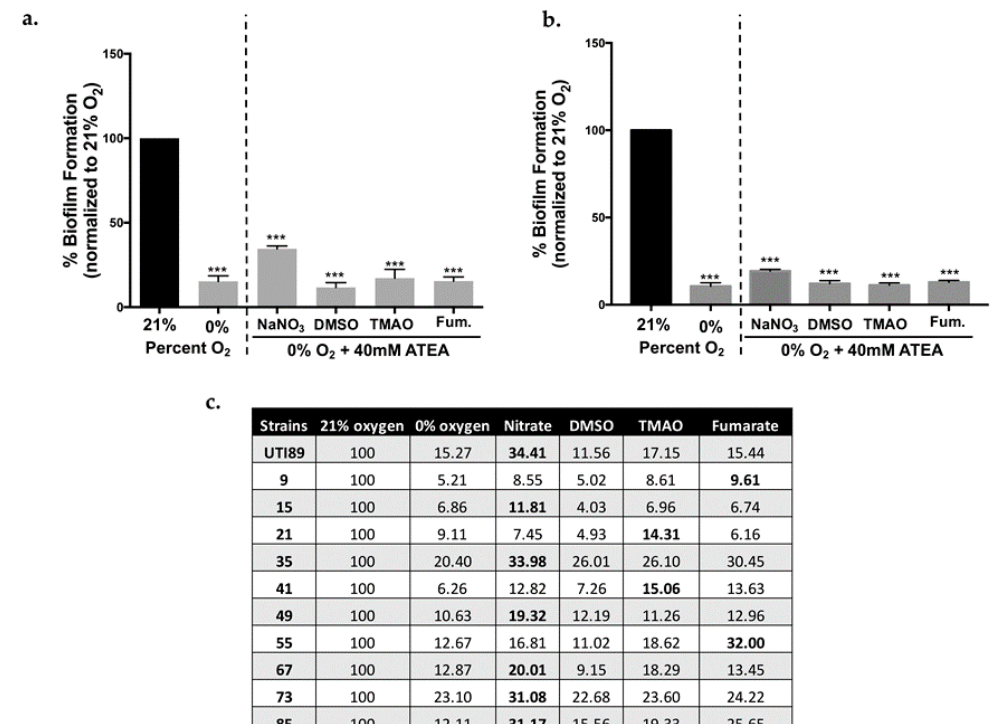
Figure 4. Alternative terminal electron acceptors do not restore biofilm formation. ( a ) Graph showing percent biofilm formation normalized to a well-characterized cystitis isolate UTI89 grown in the presence of oxygen (21%). UTI89 biofilm formation at 21% oxygen is artificially set to 100%, while the absorbance of the biofilm formed at 0% oxygen as well as at 0% oxygen with other terminal electron acceptors (40 mM) is averaged and then divided by the 21% oxygen average to calculate the percentage. Error bars represent the standard error of the mean (SEM) compared to UTI89 grown under 21% oxygen, *** p -value > 0.001; ( b ) Clinical isolate VUTI49 was tested under 21% oxygen and 0% oxygen with 40 mM of each alternative terminal electron acceptor. Percentages were calculated as in panel A and SEM is calculated compared to VUTI49 grown at 21% oxygen, *** p -value > 0.001; ( c ) Table including the percentages of biofilm formed by UTI89 and 10 randomly selected urine-associated E. coli from the panel tested in Figure 2. The highest percent biofilm formed by each strain is bolded to show the ATEA that had most effect on biofilm. The percentages were calculated as described above. Experiments were performed a minimum of three independent times.